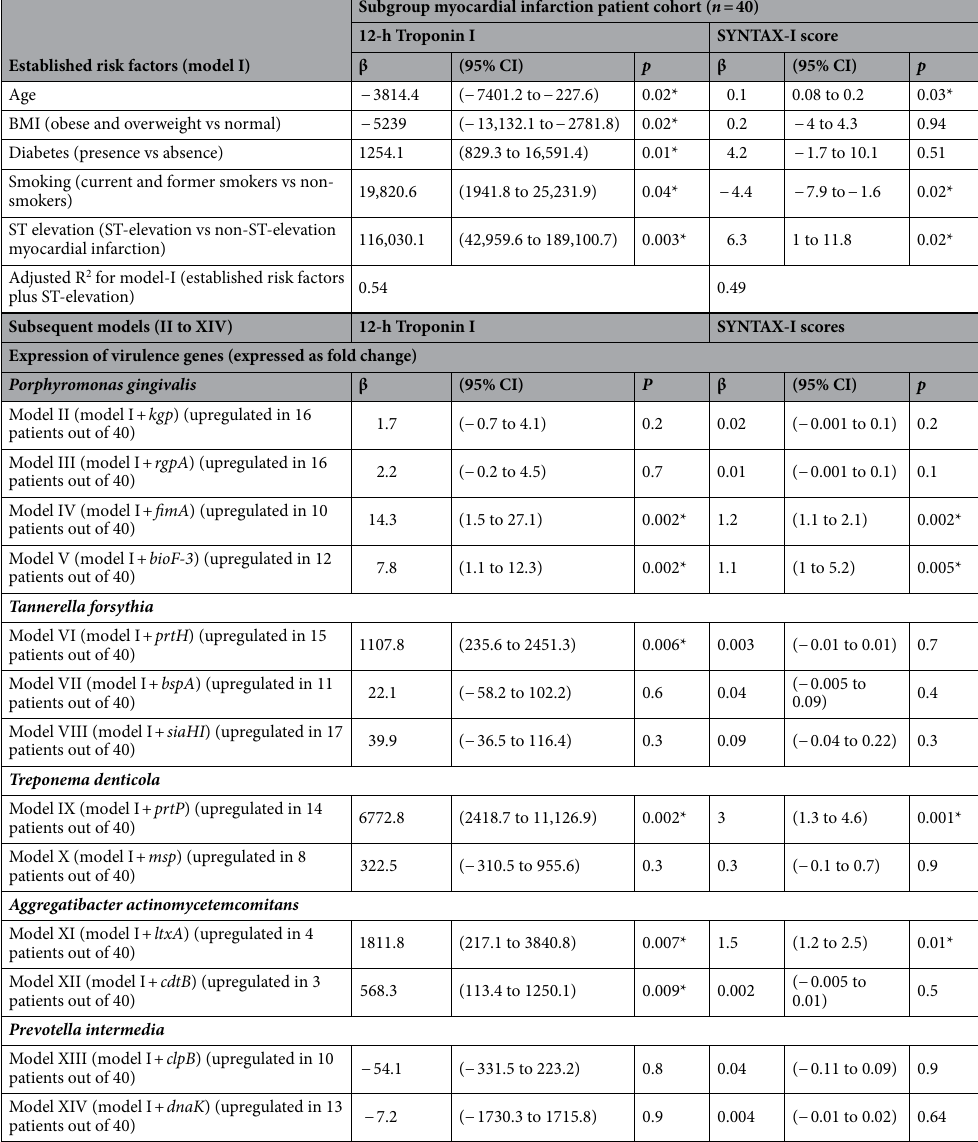
Table 4. Hierarchical linear regression of periodontal pathobionts’ virulence gene expressions with 12-h Troponin I and SYNTAX-I scores ( n = 40). The established common risk factors were introduced in model I followed by individual additions of per unit fold increase in expression levels of P. gingivalis -related virulence genes: kgp (model II), rgpA (model III), fimA (model IV), bioF-3 (model V); followed by T. forsythia- related genes: ltxA (model XI), cdtB (Model XII); followed by P. intermedia -clpB (model XIII), dnaK (model XIV). R 2 coefficient of determination, β unstandardised regression coefficient, CI confidence interval. * = statistically significant ( p < 0.05), BMI body mass index, SIMD Scottish Index of. Multiple Deprivation, SYNTAX The Synergy between percutaneous coronary intervention with TAXUS drug-eluting stent and Cardiac Surgery